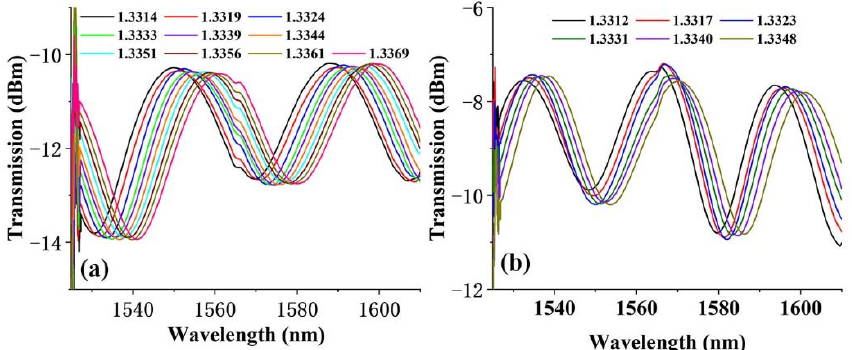
Figure 6. Interference spectra as a function of refractive index of the microfiber elaborated with ( a ) silver and ( b ) silicon NPs with same concentration of 0.5 mol/L.